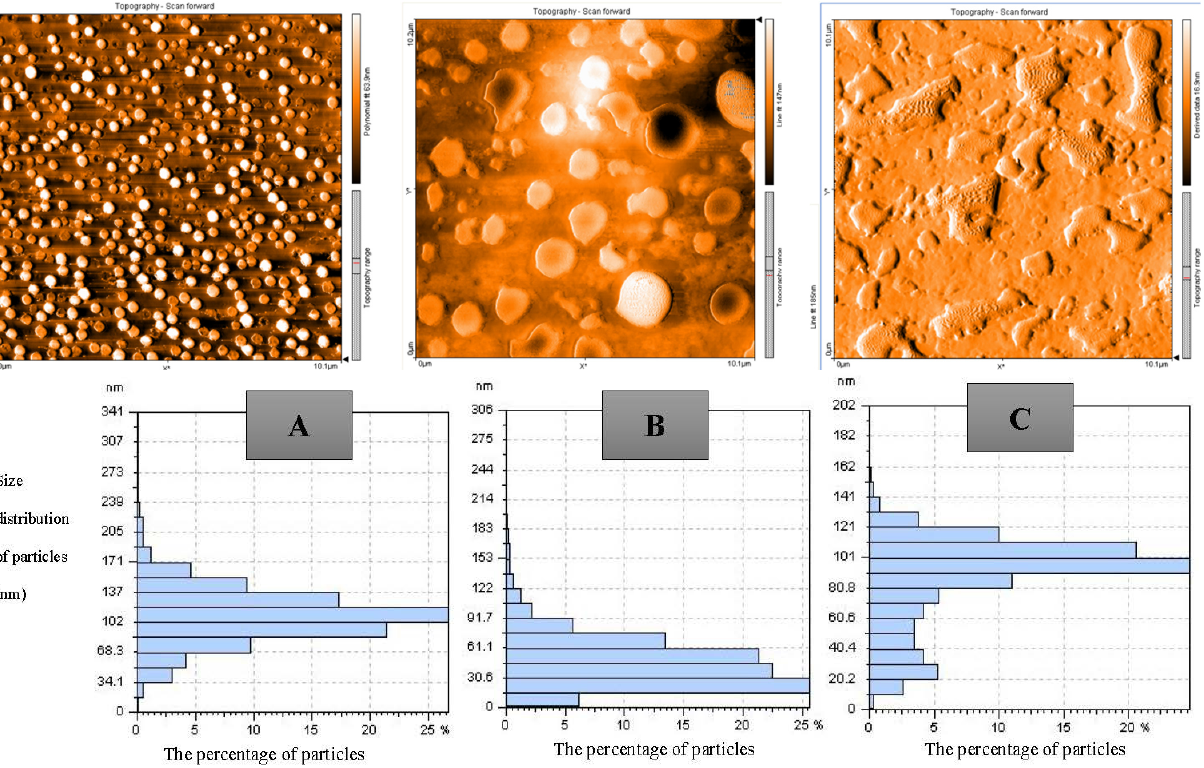
Figure 3. AFM images (3D) and particle size distribution obtained from WPC–pectin complexes in three powders: ( A ) NC3, ( B ) NC6, and ( C ) NC9.